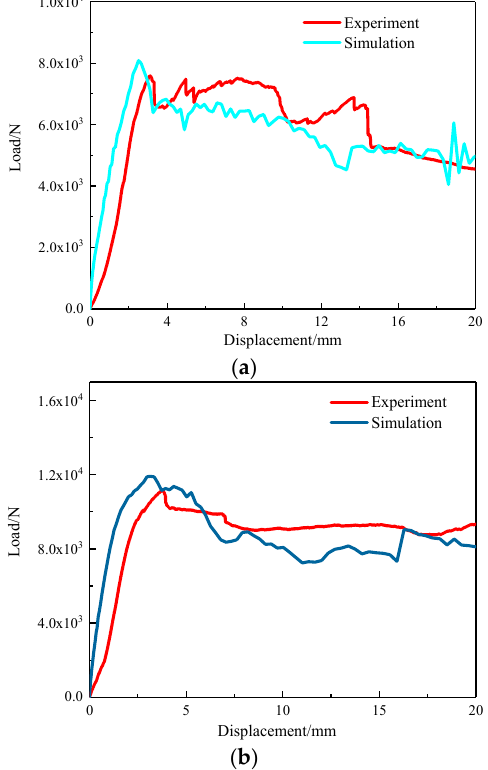
Figure 15. Load–displacement curves of three-point bending process of composite sandwich laminated box beams. ( a ) Aluminum honeycomb core; ( b ) Aluminum foam